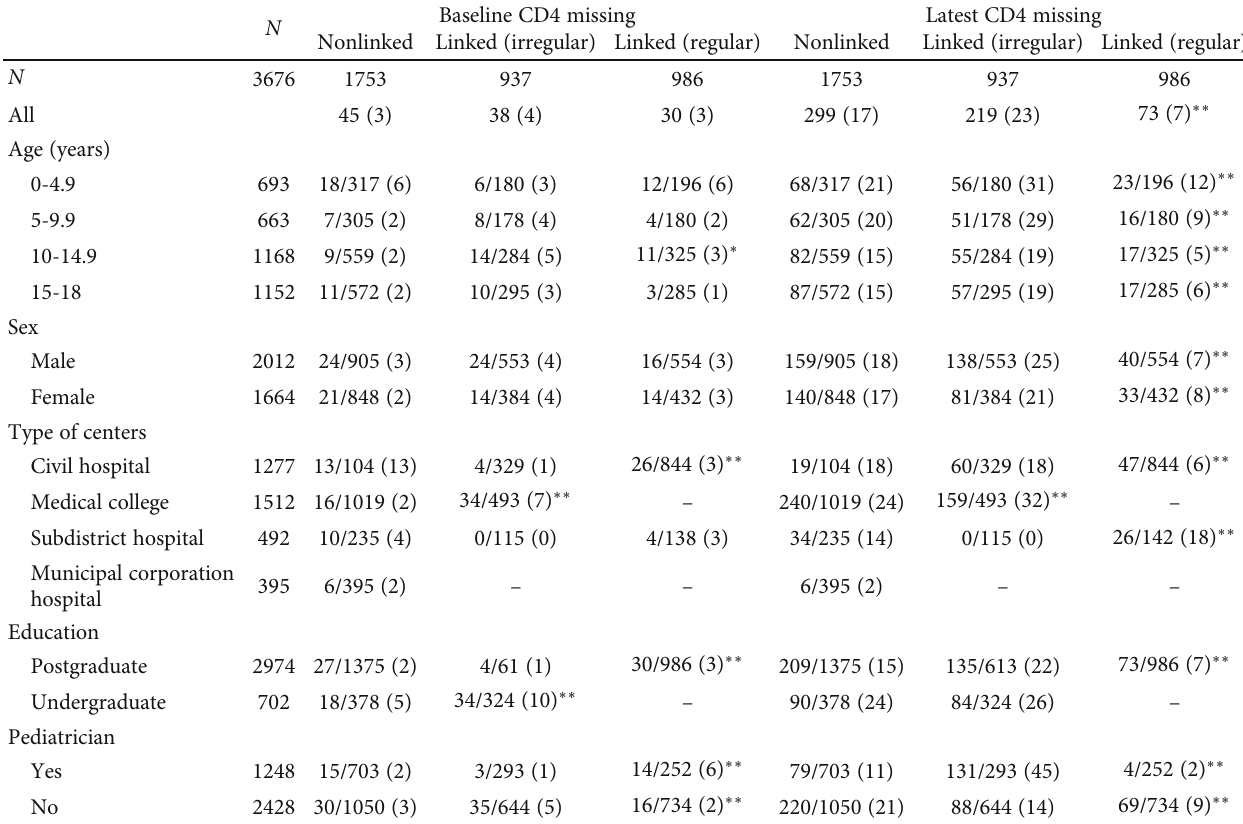
Table 6: Table showing certain quality of care indicators according to demographics in 3676 children on ART in 59 ART centers,